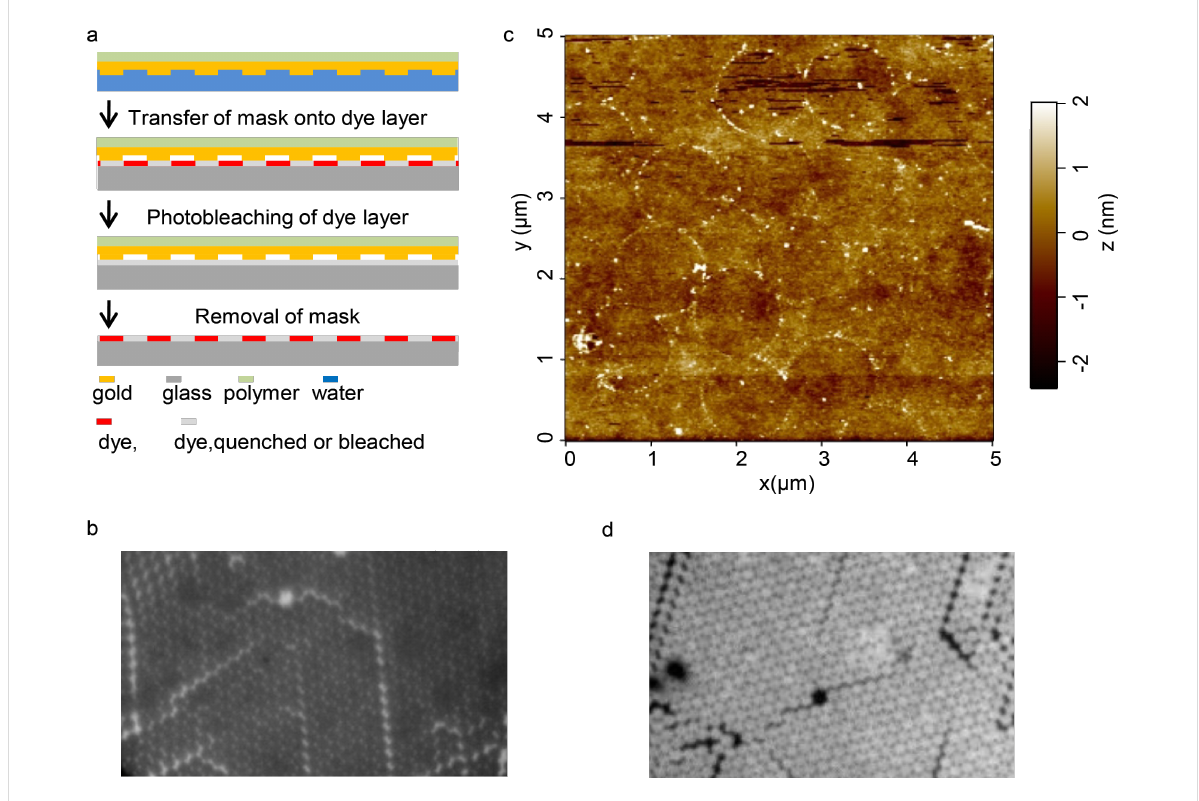
Figure 2: Photochemical near-field lithographic process 1: (a) Schematic outline of the steps involved in this process. Mask 1 is transferred to a fluo- rescent SAM. Light exposure leads to photobleaching of the unprotected areas. Removal of the mask after photobleaching releases the remaining molecules from the quenched state. (b) Epi-fluorescence image of a fluorescein monolayer after bleaching and removing the mask 1. (c) AFM topog- raphy image of the photochemical modification of the fluoresceine monolayer reveals a small topographic step from bleached to unbleached regions. (d) Epi-fluorescence image of a fluoresceine monolayer in close contact with mask 2.